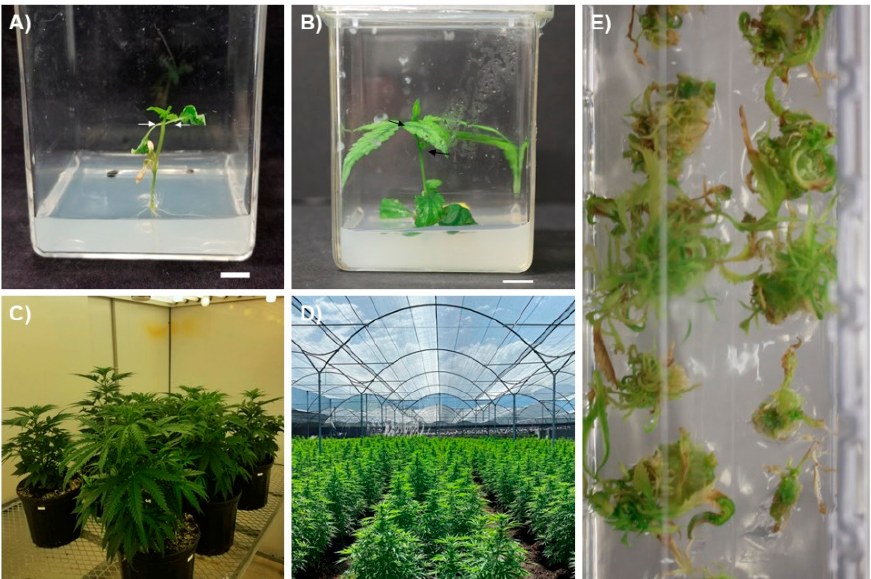
Figure 2. ( A ) In Vitro germinated seedling of C. sativa demonstrating opposite leaf arrangement. White arrows show oppositely oriented first true leaves. Scale bar—1 cm. ( B ) A Stage 2 vegetative explant (subcultured from a nodal explant) of C. sativa demonstrating alternate leaf arrangement (black arrows), a change in phyllotaxy resulting from explant maturation. Scale bar—1 cm. ( C ) C. sativa grown in controlled environment growth chambers under fluorescent lighting. ( D ) C. sativa grown outdoors under a shade cloth in Colombia. Image supplied courtesy of Avicanna™. ( E ) Hyperhydric C. sativa explants growing on Murashige and Skoog (MS) medium supplemented with 0.5 µM thidiazuron (TDZ).